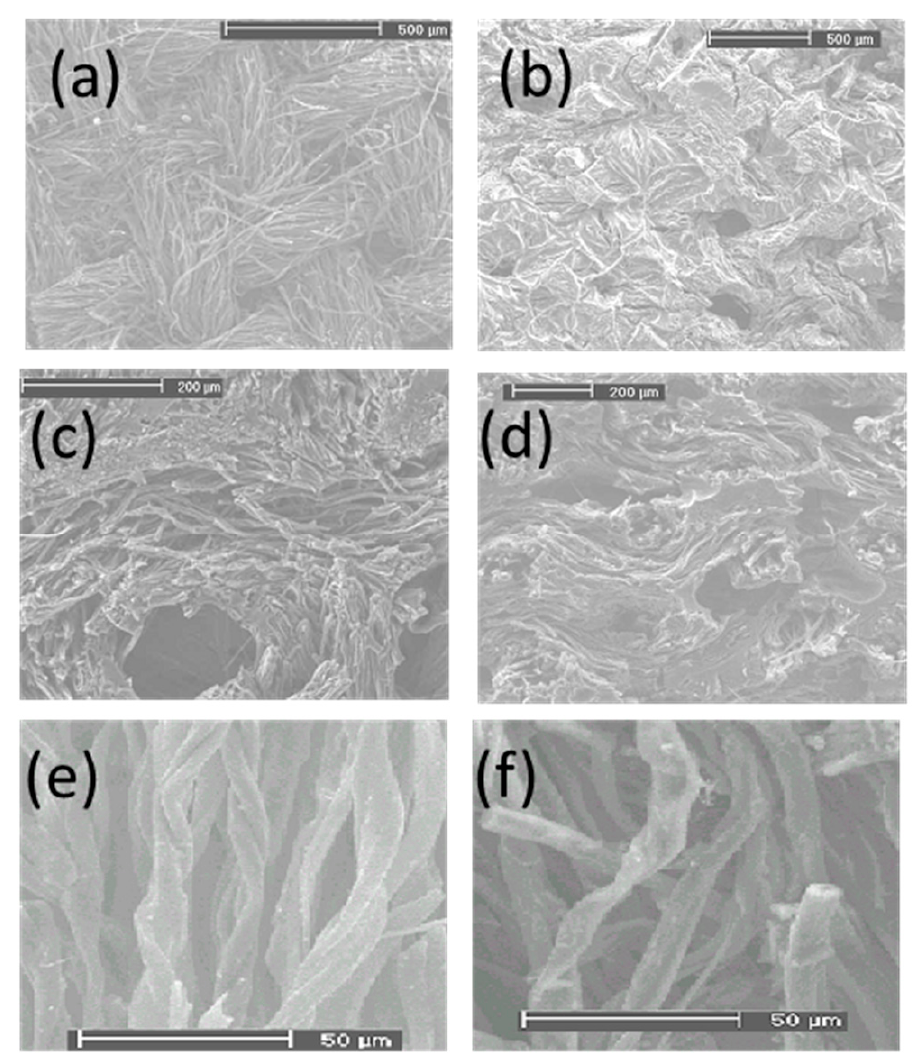
Figure 3. SEM micrographs of the carbonized materials: ( a ) carbonized fabric ( b , c ) carbonized composite (surface); ( d ) carbonized composite (fracture), ( e ) carbonized fabric, ( f ) carbonized c(RF@F) (surface). The macropores arise from the holes in the fabric and the space between fibers. Therefore, even if a macroscopically compact fabric is used (e.g., non-woven fabric), the space between fibers would act as